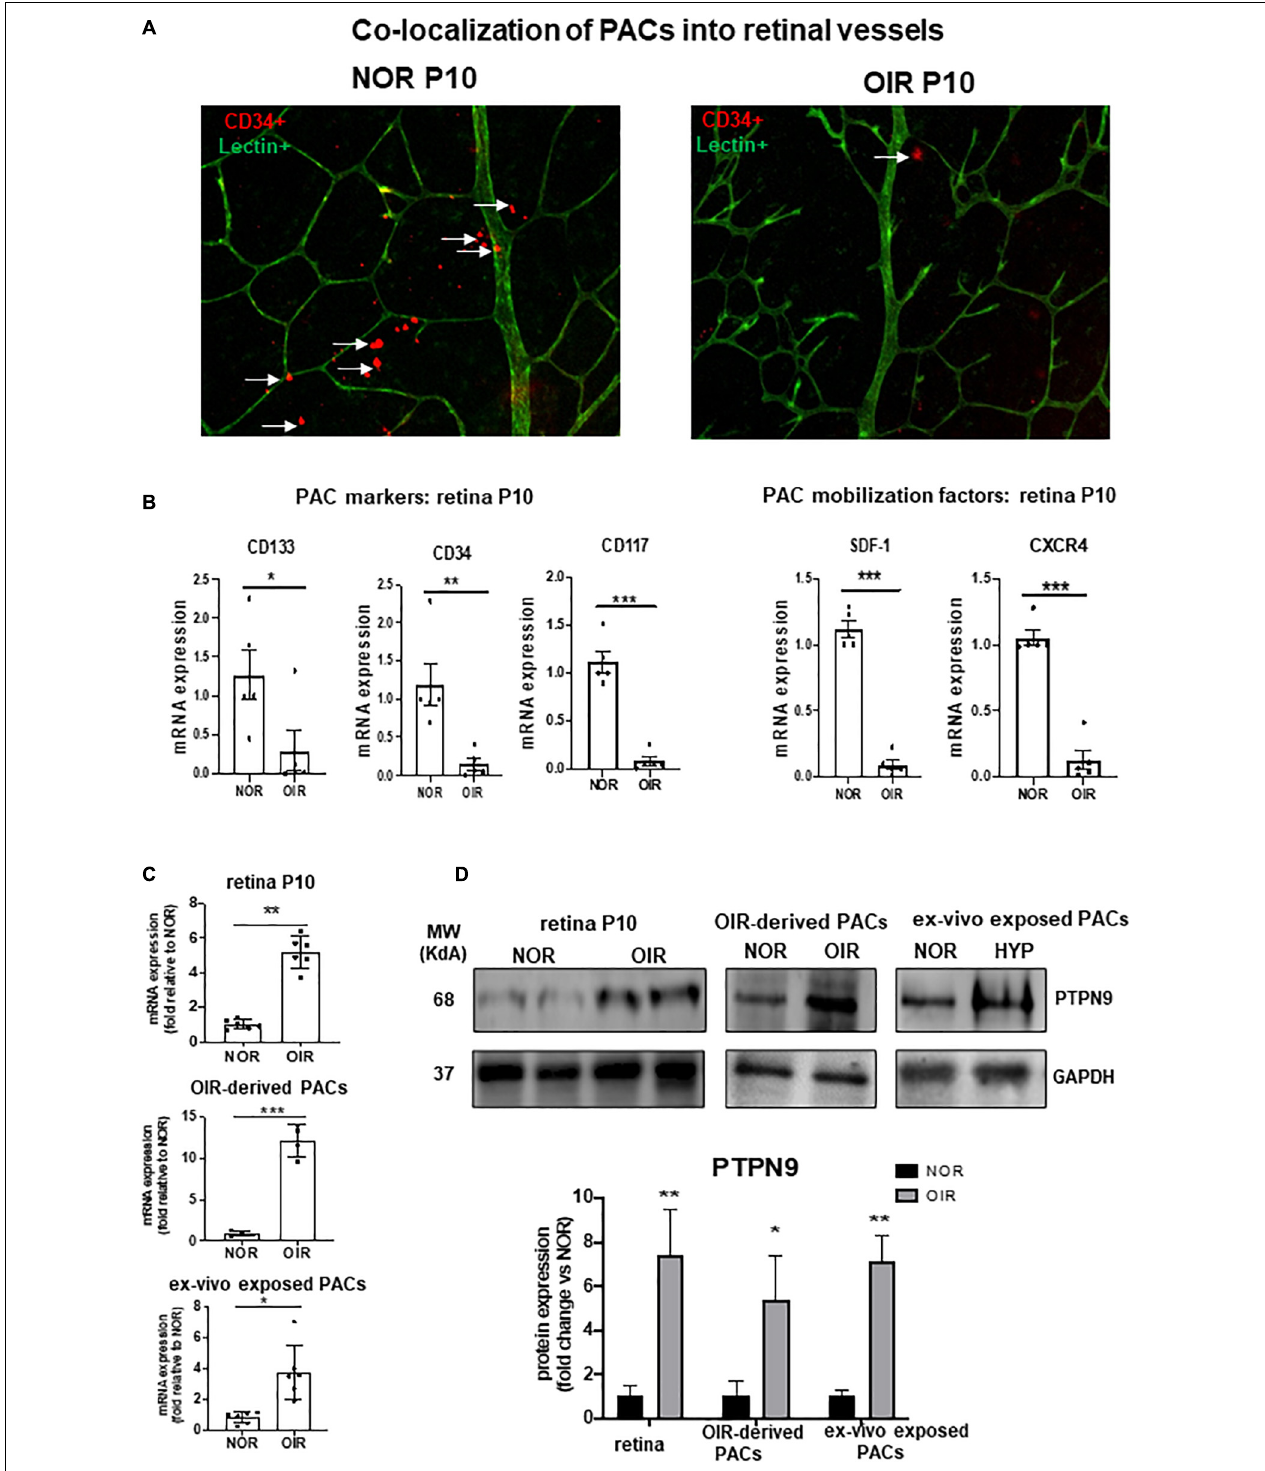
FIGURE 3 | PAC recruitment in retinal vessels is decreased during OIR and associated with increased PTPN9 expression. (A) Representative flat mount images of retinal vascularization at P10 showing co-localization of CD34 + PACs (red) with lectin positive vessels (green) in OIR-subjected rats vs. control rats kept in normoxic conditions (NOR). (B) mRNA expression levels of PAC markers and PAC mobilization factors in the retinas of OIR vs. NOR rats at P10. (C,D) mRNA (C) and protein (D) expression levels of PTPN9 in OIR vs. NOR rats in the retina during OIR at P10, and in PACs isolated from OIR rats or PACs exposed ex vivo to hyperoxia. Data are mean ± SEM. * P < 0.05 or ** P < 0.01 or *** P < 0.001 vs. control (NOR). N = 6–8.